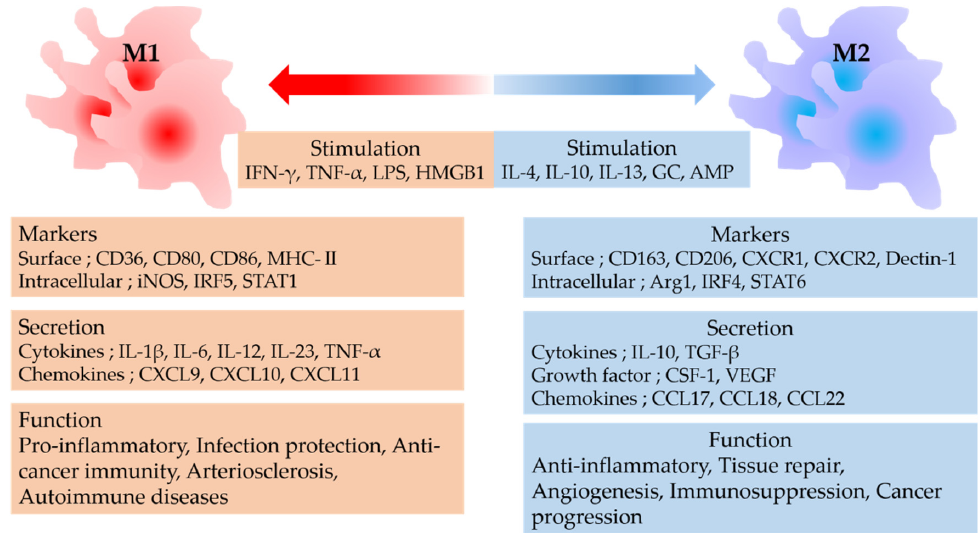
Figure 1. M1 macrophages are induced by IFN- γ and LPS, whereas M2 macrophages are induced by IL-4 and IL-10. M1 macrophages exert pro-inflammatory, anti-infectious, and antitumor immunity; these are responsible for inflammatory and autoimmune diseases. M2 macrophages exert anti- inflammatory effects and tissue repair but often promote tumor progression. IFN, interferon; TNF, tumor necrosis factor; LPS, lipopolysaccharide; HMGB1, high mobility group box-1 protein; IL, interleukin; GC, guanylate cyclase; AMP, adenosine monophosphate; CD, cluster of differentiation; MHC, major histocompatibility complex; NOS, nitric oxide synthase; IRF, interferon regulatory